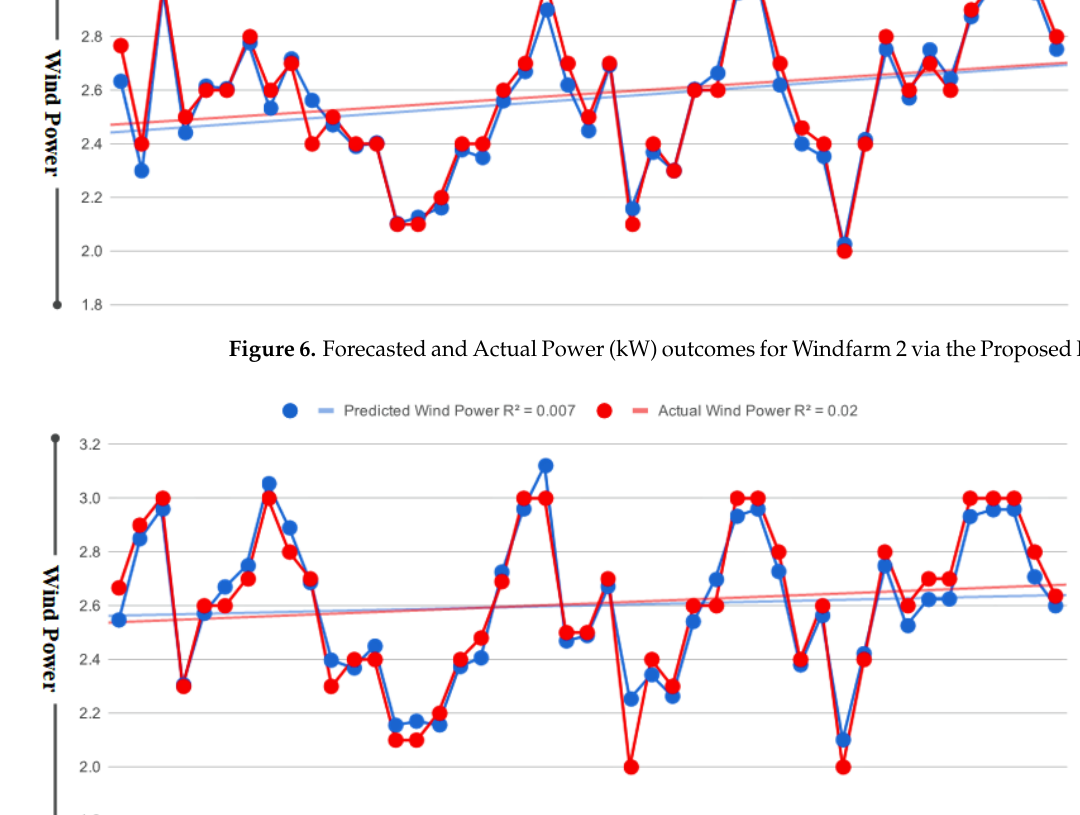
Figure 6. Forecasted and Actual Power (kW) outcomes for Windfarm 2 via the Proposed Methodology.